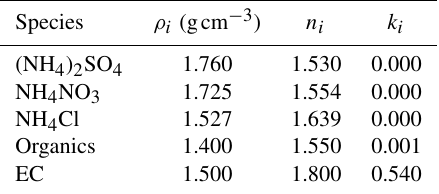
Table 1. Summary of the parameters for calculating the average optical refractive